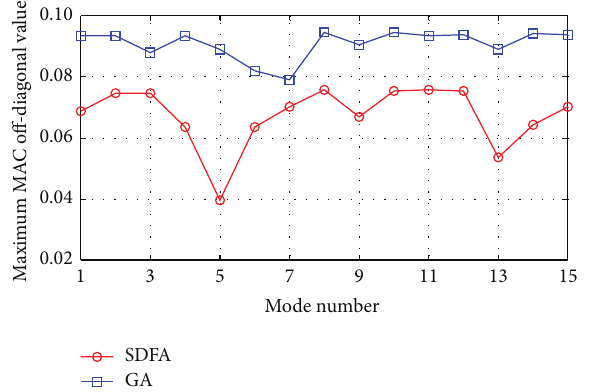
Figure 7: Maximum MAC off-diagonal values in each of the